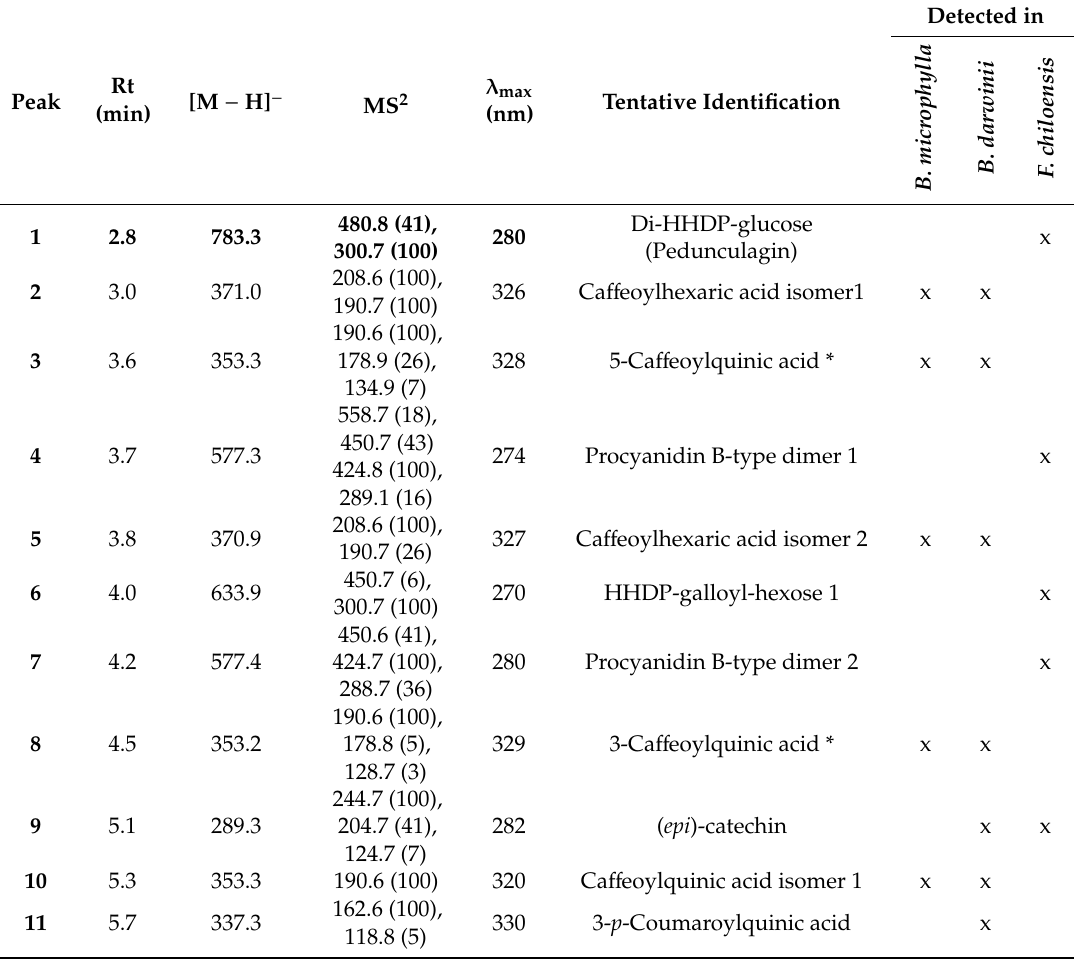
Table 3. Characterization and distribution of phenolic compounds in wild Argentinean